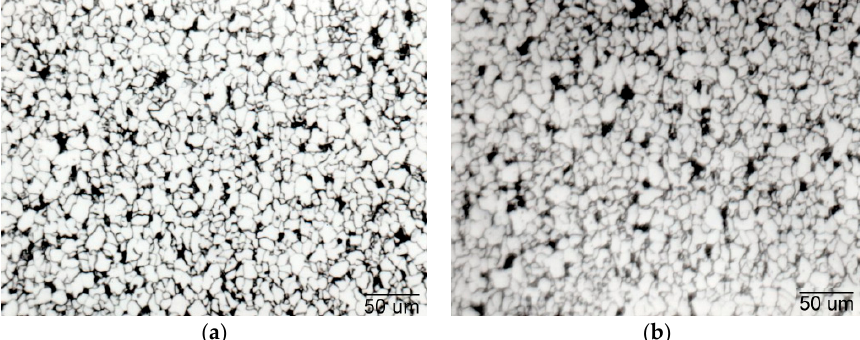
Figure 10. Microstructure of the hot rolled strips of Nb microalloyed steel. ( a ) LT variant. ( b ) HT